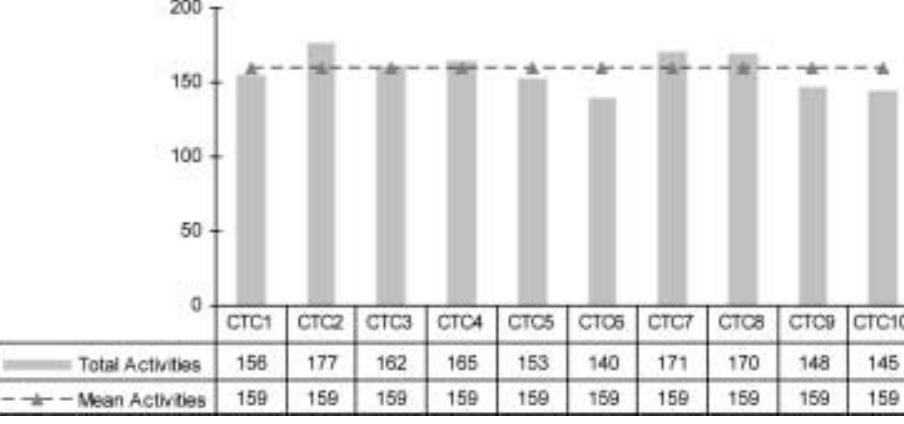
Figure 2. Learning activity